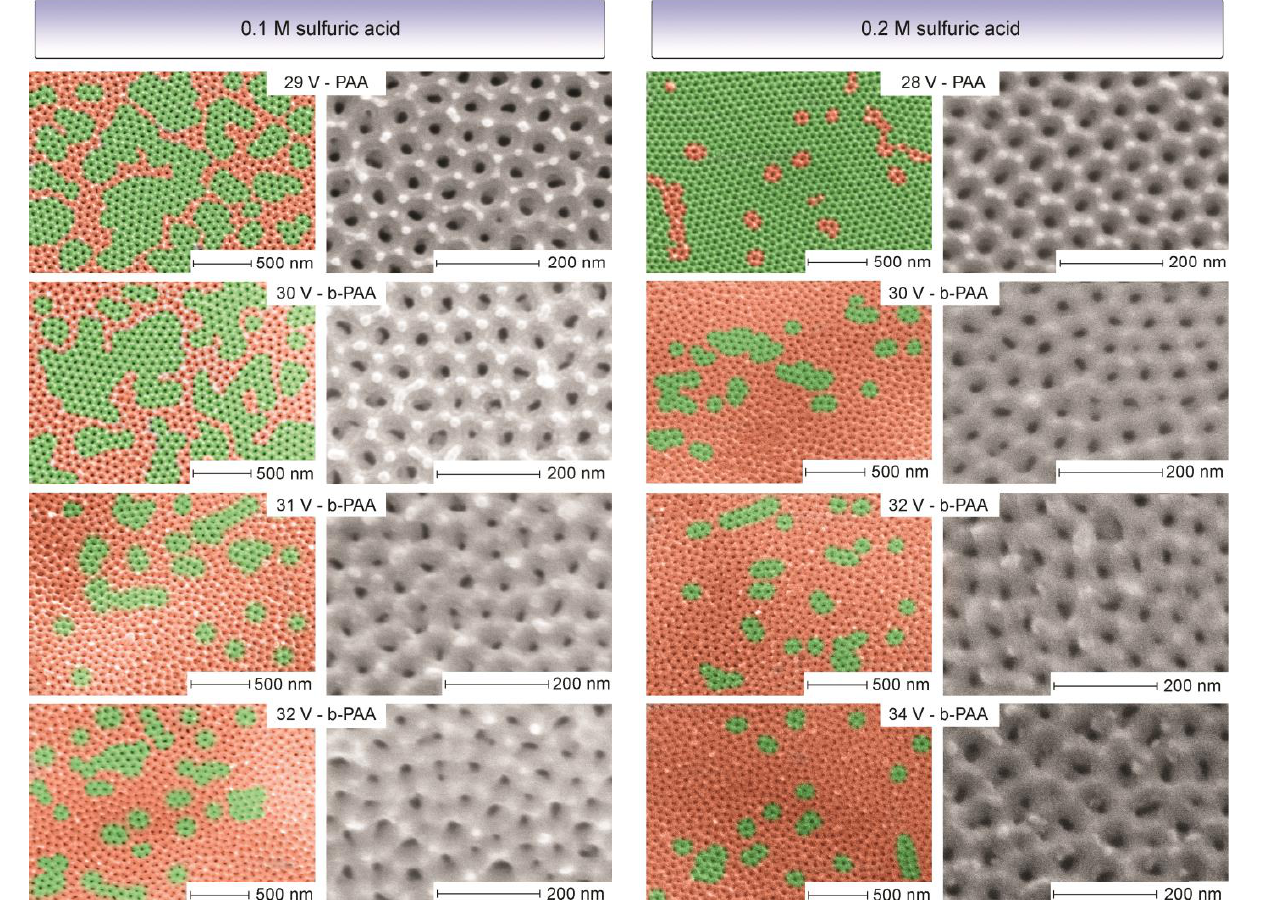
Figure 2. The reverse evolution of the long-range ordering at the nanoscale level in anodic alumina films upon the increase of anodizing voltages and transition from transparent porous anodic alumina (PAA) to optically black (b-PAA) layers in 0.1 M and 0.2 M H 2 SO 4 electrolytes (all samples are analyzed underneath a scanning electron microscope (SEM) at consistent 80 000× and 350 000× magnifications). The hexagonally ordered photonic crystal-like areas are color-coded as green; the disordered areas containing randomly coordinated pores are color-coded as red. The apparent difference can be observed between macroscopically transparent PAA (0.1 M @ 29 V and 0.2 M @ 28 V) where the long-range ordered domains are prevailing, and the b-PAA samples that are predominantly disordered. The mixed semi-ordered character of the sample corresponding to 0.1 M @ 30 V may serve as an explanation of the transitional (semi-translucent and semi-blackened) macroscopic visual appearance in Figure 1.